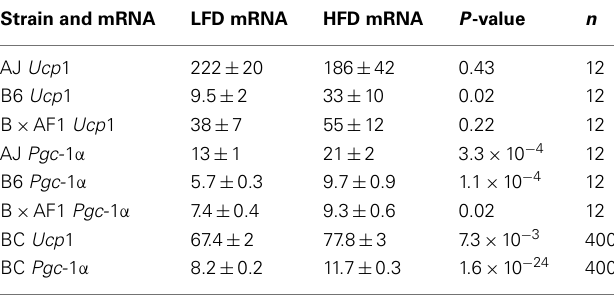
Table 1 | Effects of a high fat diet on Pgc- 1 α and Ucp 1 mRNA